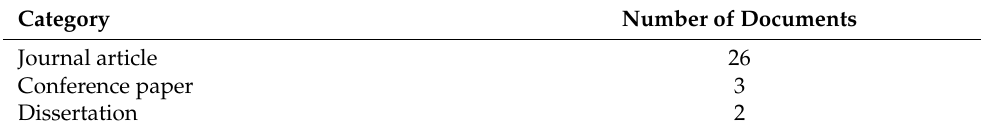
Table 5. Collected articles titled human